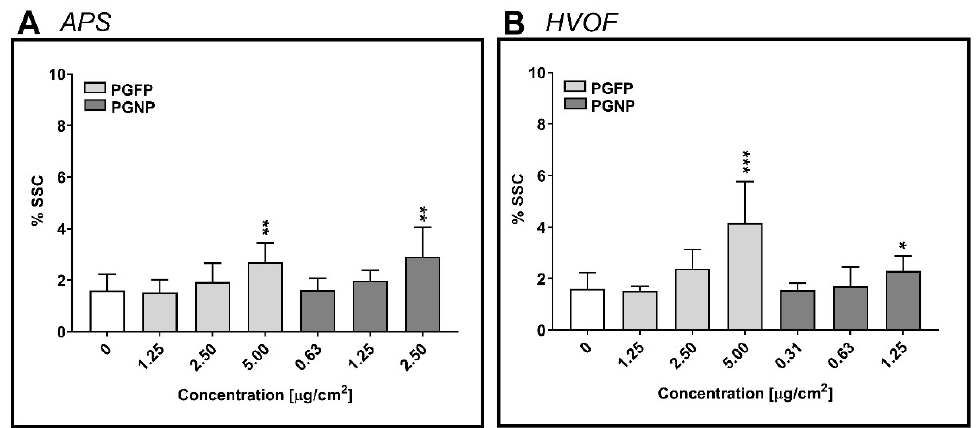
Figure 3. Cellular uptake of PGFP and PGNP released during APS ( A ) and HVOF ( B ) by human alveolar epithelial A549 cells after 24 h of exposure, as estimated by variations in the side scatter signal (SSC). Data are expressed as means ± standard deviations (n = 3–4). Data were analysed by the one-way ANOVA test followed by Dunnett’s post hoc test for multiple comparisons. * p ≤ 0.05, ** p ≤ 0.01 and *** p ≤ 0.001 vs. NC.